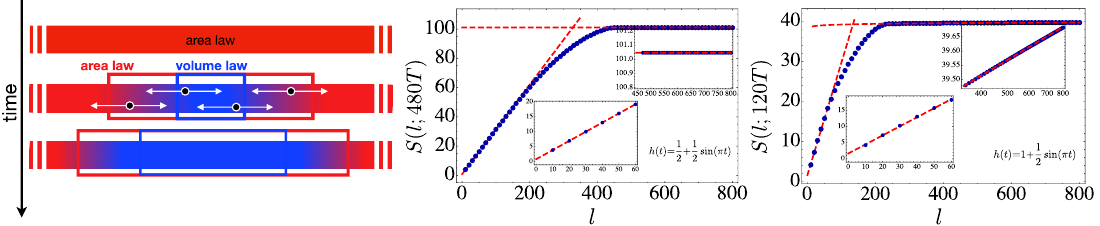
Figure 1. ( left ) For a non-critical (critical) system at t = 0 an area (log) law for the entanglement entropy is satisfied. At t > 0, the periodic drive is responsible for the appearence of quasi-particle travelling along the chain entangling the spins in the region they have spanned, i.e., l = 2 v max t , and represented in the left figure by arrows. If the subsystem is chosen such that the arrows span over its whole size, every spin in it is entangled with spins outside and a volume law follows (blue box), otherwise an area (log) law holds (red box). A snapshot of the entanglement entropy for different subsystem sizes l in a spin chain of N = 8192 for a periodic drive far from criticality after n = 480 cycles ( left ) and at criticality after n = 120 cycles ( right ). The insets show the coexistence of a volume with an area and with a log law, respectively.